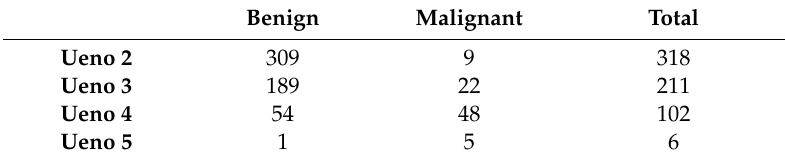
Table 5. Qualitative real-time elastography scores and malignancies (1405